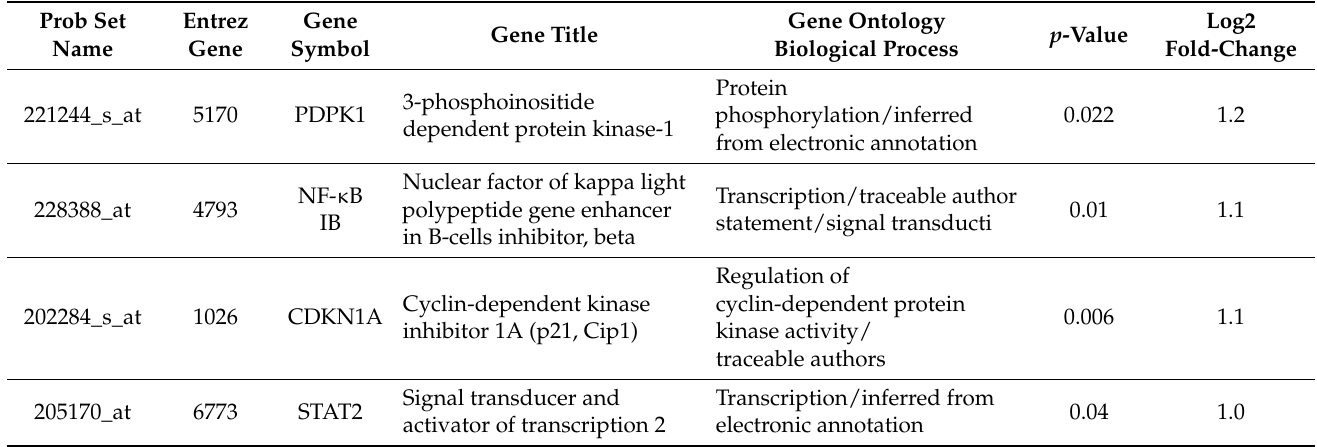
Table 6. Differential expression of 10 transcripts based on fold change annotated to genes that are involved the interleukin signalling pathway (High magnesium